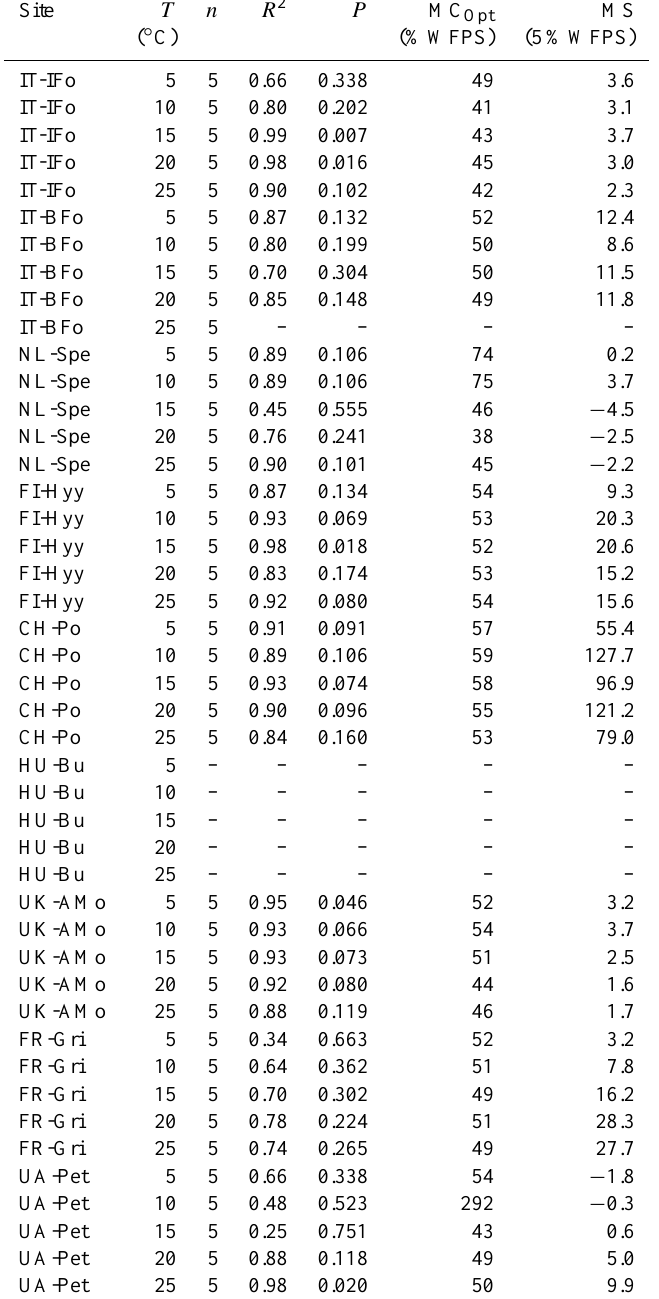
Table 4. Regression analysis of moisture relationship of heterotrophic soil respiration at all temperatures investigated (polynomial second degree); determination coefficient R 2 , standard error of estimate, significance level P , and number of observations n (mean values over six replicants; relative values); optimum moisture content (MC Opt ), calculated as the MC where moisture sensitivities cut the x axis and CO 2 emissions show their optimum; and calculated moisture sensitivity (MS) at 5% WFPS to show the temperature dependence of